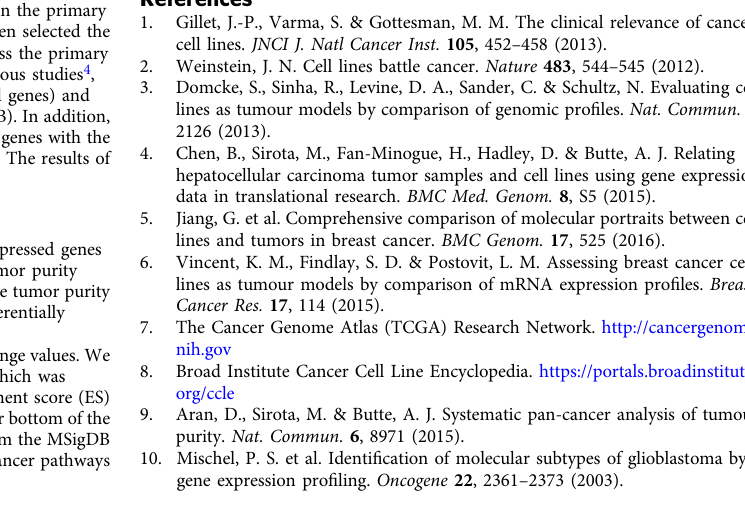
Fig. 5 The TCGA-110-CL: an improved cell line panel integrating TCGA and CCLE data. a Heatmap of correlations between cell lines in the NCI-60 panel and primary tumor data. Only 36 cell lines which are shared between NCI-60 panel and CCLE are shown. The tumor types of each cell line are indicated by the annotation bar to the left of the heatmap. b Heatmap of improved NCI-60 panel. Improved panel has the same number of cell lines and tumor types as the original NCI-60 panel, but the cell lines with the highest correlations with their matched primary tumor samples were selected. c Boxplot showing that the improved NCI-60 panel has signi fi cantly higher correlations (two-sided Wilcoxon test p -value = 7.6e-07) with their matched primary tumor samples compared with the original NCI-60 panel. The center line in the boxplot depicts the median, the box limits depict the upper and lower quartiles, and the whiskers depict 1.5 times the interquartile range (IQR). d Proposed TCGA-110-CL panel. An improved cell line panel that includes fi ve cell lines with the highest correlations to their matched primary tumor samples across 22 tumor types. For the tumor types with subtype predictions, cell lines with the highest correlations within each subtype were chosen to maximize subtype representation in the